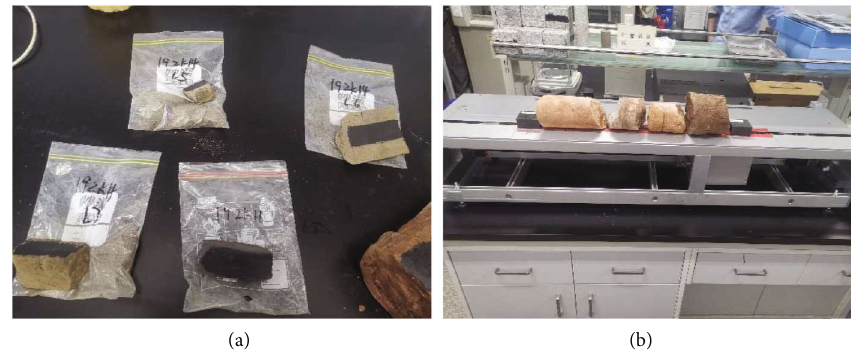
Figure 3: Core drilling of K11 and K14 (a) and testing process (b).